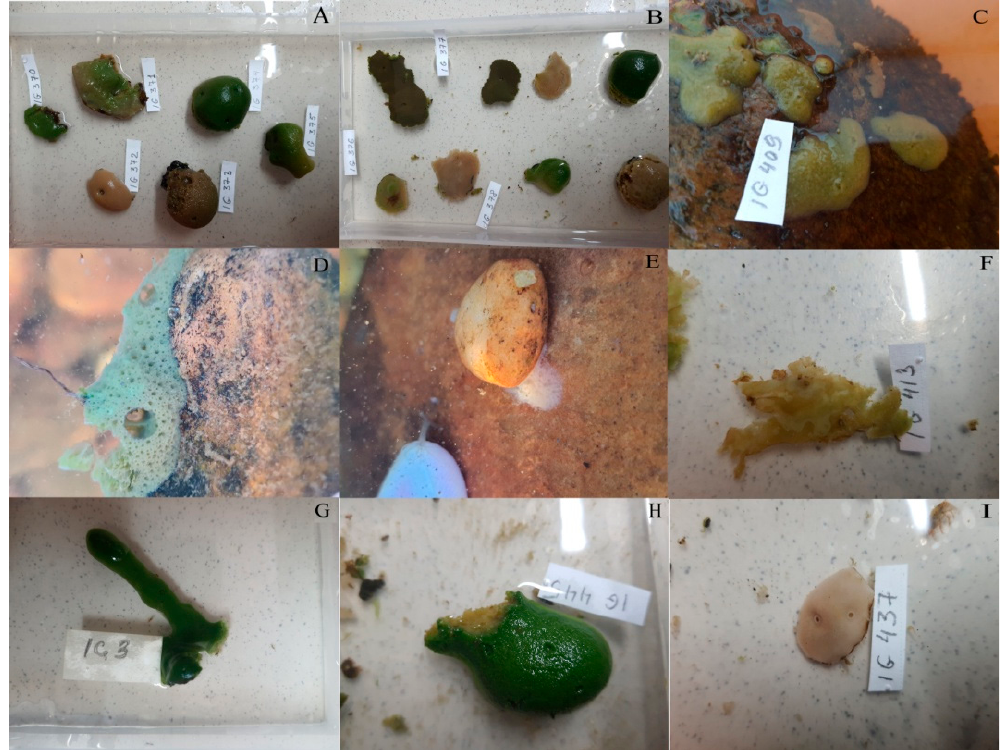
Figure 1. ( A , B ) In vivo and ( C ) in situ photos of Lubomirskiidae from Lake Baikal; ( D , E ) In situ and ( F ) in vivo photos of Spongillidae from Lake Baikal; ( G ) L. baikalensis ; ( H ) B. bacillifera ; ( I ) S. papyracea .